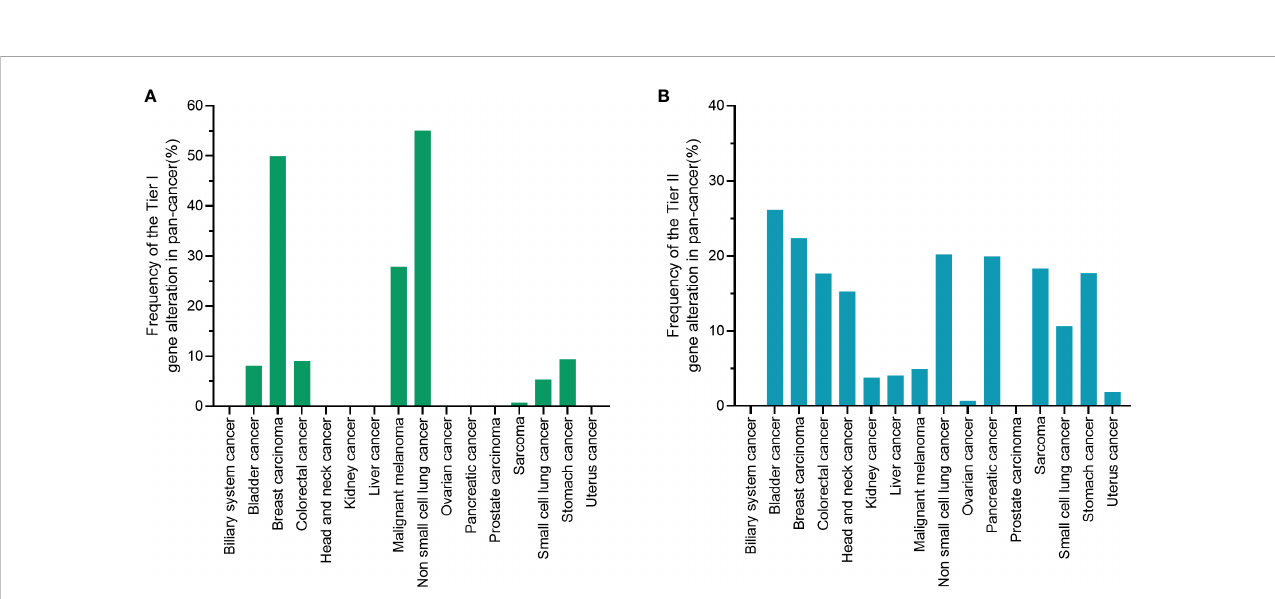
FIGURE 4 Tier I or tier II alterations in 17,841 pan-cancer patients. (A) Tier I variants are of strongest clinical signi fi cance, and include level A evidence (FDA- approved therapy included in professional guidelines) and level B evidence (well-powered studies with consensus from experts in the fi eld). (B) Tier II alterations re fl ect the possibility of off-label use of a targeted drug in pan-cancer patients. A tier II variant was de fi ned as a variant of potential clinical signi fi cance, and included level C evidence (FDA-approved therapies for different tumor types or investigational therapy, multiple small published studies with some consensus) and level D evidence (preclinical trials or a few cases reports without consensus). FDA, food and drug